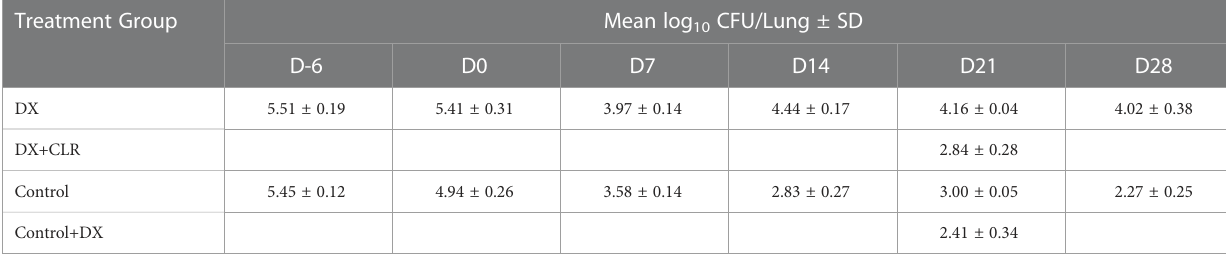
TABLE 7 M. abscessus burden in the lungs of mice receiving different corticosteroid treatments. Treatment Group